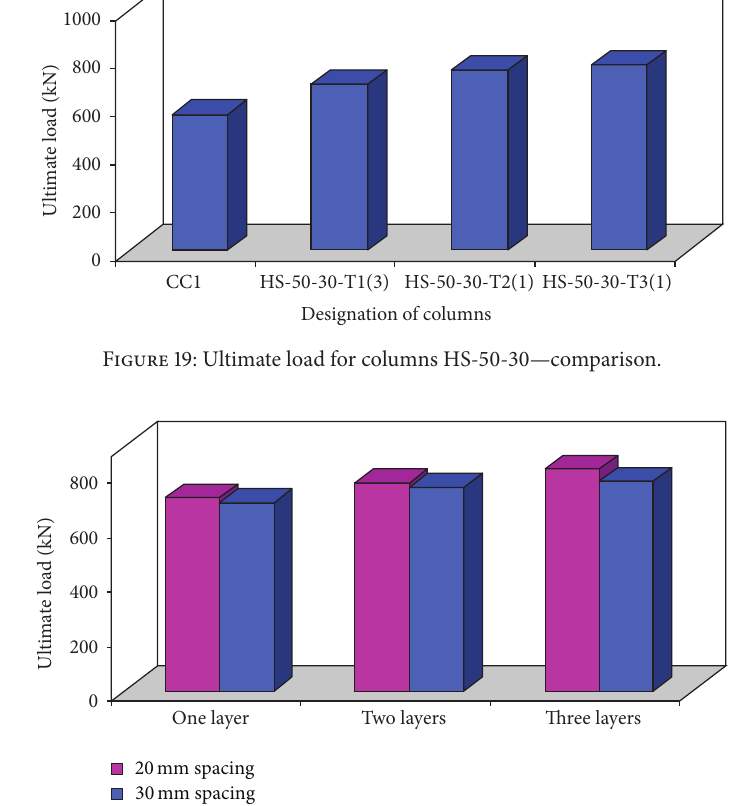
Figure 20: Ultimate load for all